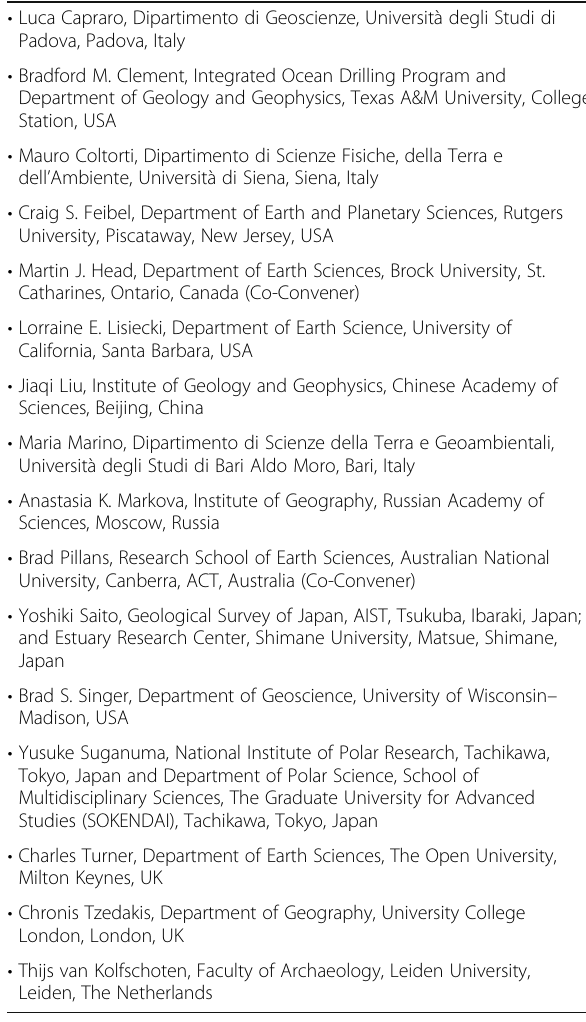
Table 1 Members of the SQS Working Group on the Early – Middle Pleistocene Boundary in 2017 at the time of voting on the